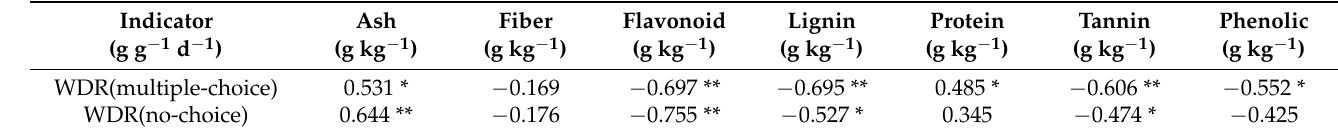
Table 3. Correlation of organic chemical characteristics of decaying leaf litter and feeding indicators of Pomacea canaliculata